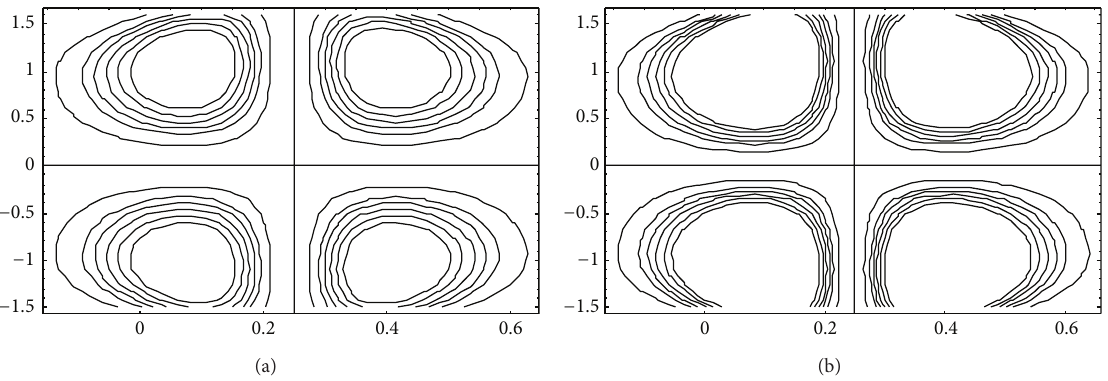
Figure 7: Streamlines when 𝛽 = 0.05 , 𝐸 1 = 0.1 , 𝐸 3 = 0.1 , 𝜀 = 0.1 , 𝛿 = 0.01 , 𝑡 = 0.0 , 𝑅 = 0.01 , 𝑀 = 1 , 𝜆 1 = 0.1 , and 𝜆 2 = 0.05 . (a) 𝐸 2 = 0.1 and (b) 𝐸 2 = 0.3 .